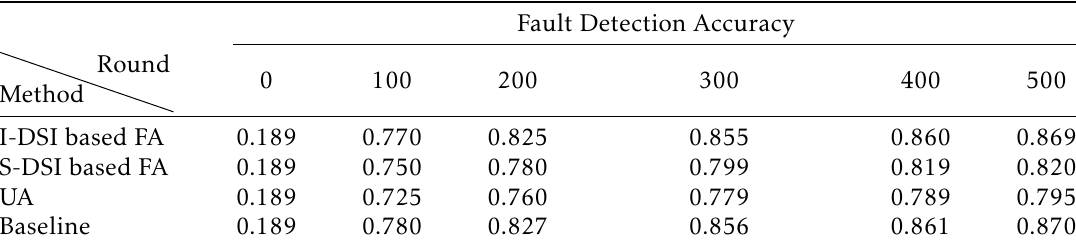
Table 1. Fault detection accuracy of FA schemes along with FMN and delay limit β